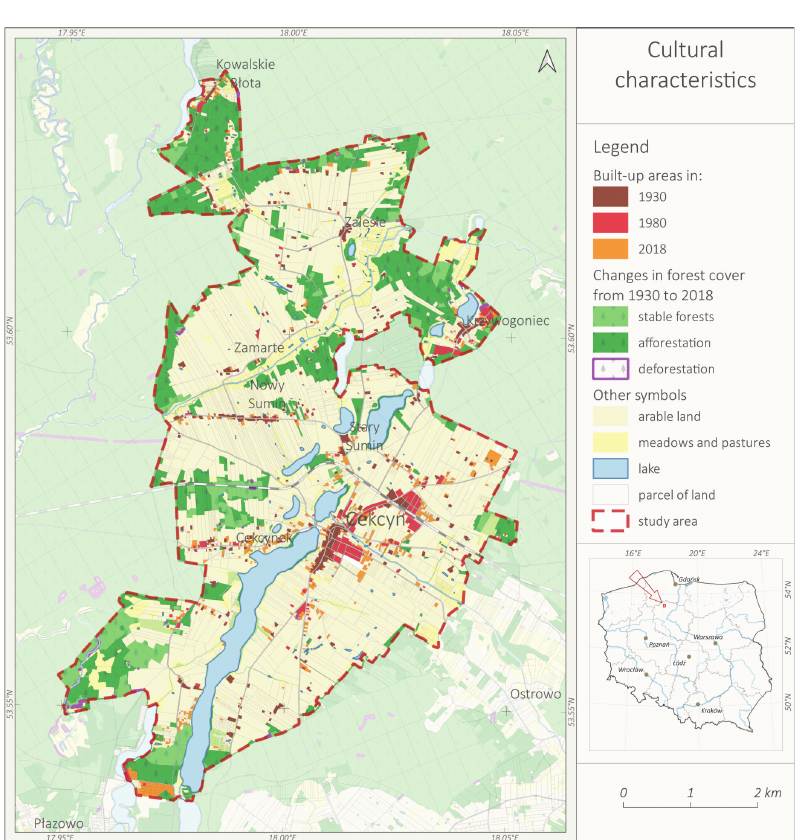
Figure 3. Designated cultural characteristics in the study